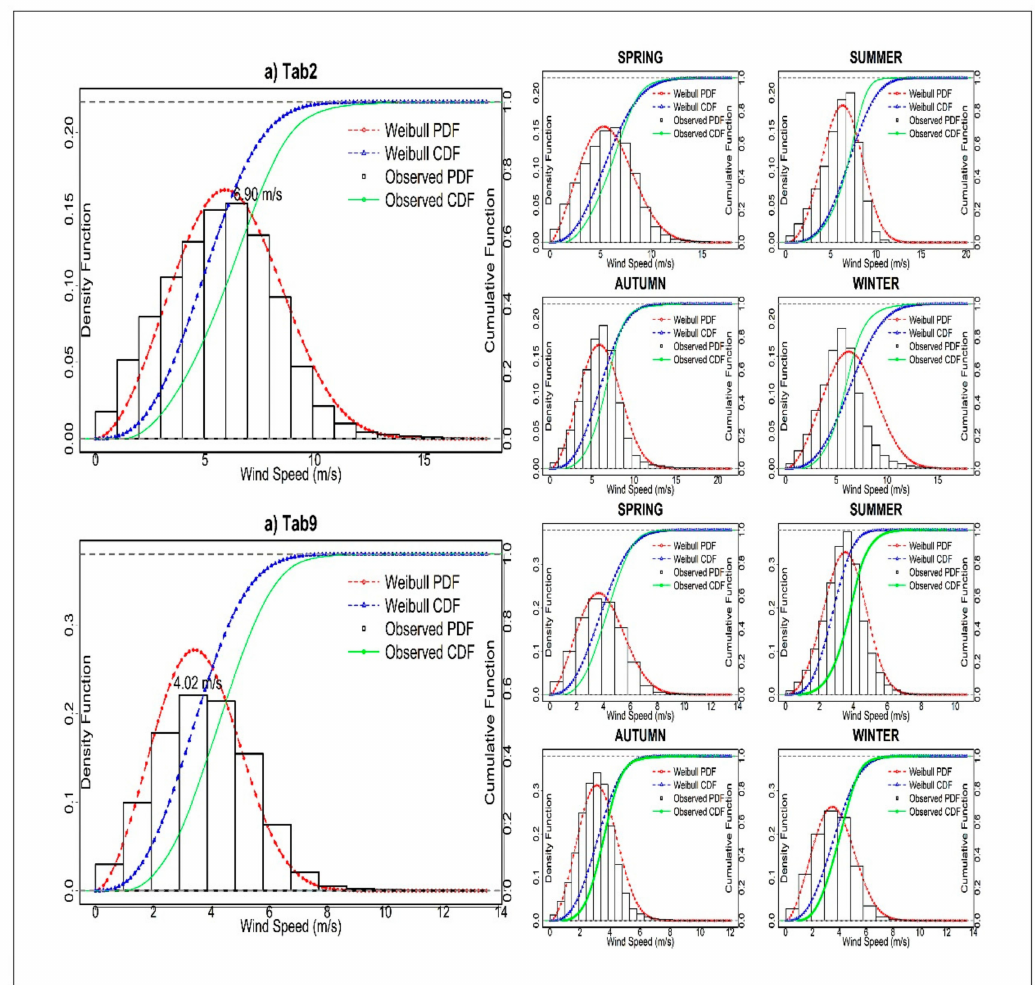
Figure 6. Annual and seasonal Weibull distributions for the state of